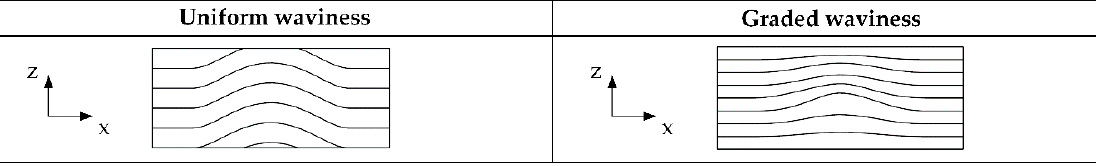
Figure 29. Uniform vs. graded waviness.